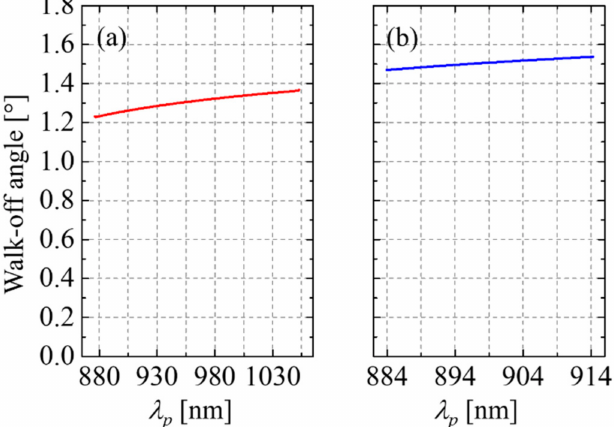
Figure 5. Maximum walk-o ff angle ( w ) of the interacting beams for ( a ) Type I and ( b ) Type II calculated numerically under the EPM